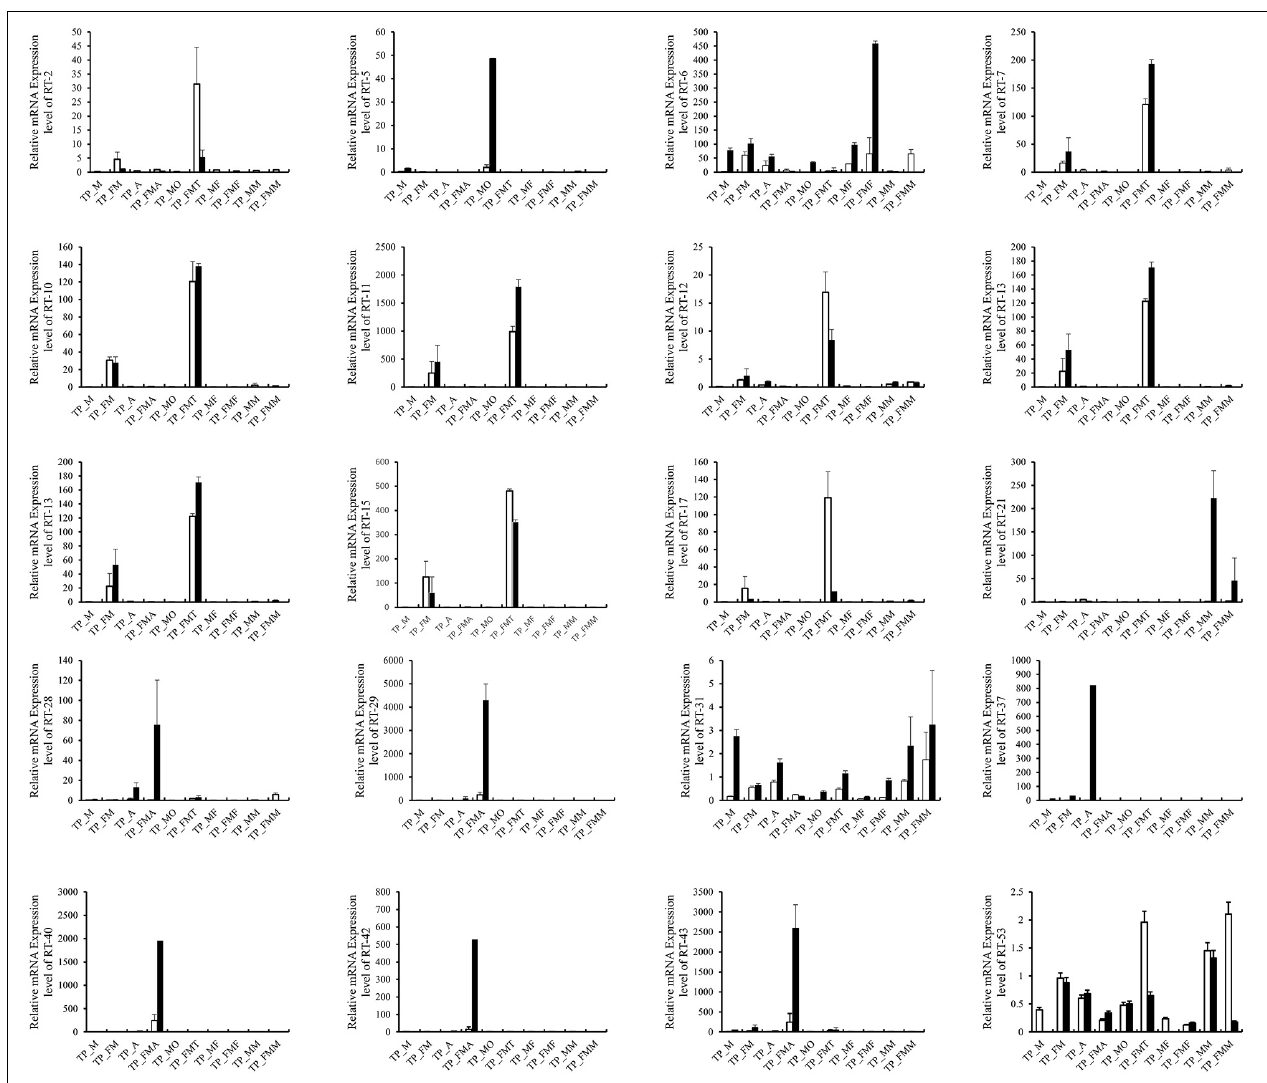
FIGURE 7 | Comparison of qRT-PCR expression level and FPKM expression level of 20 genes in T. papillosa. The white column is the qRT-PCR data, and the black column is the RNA-SEQ